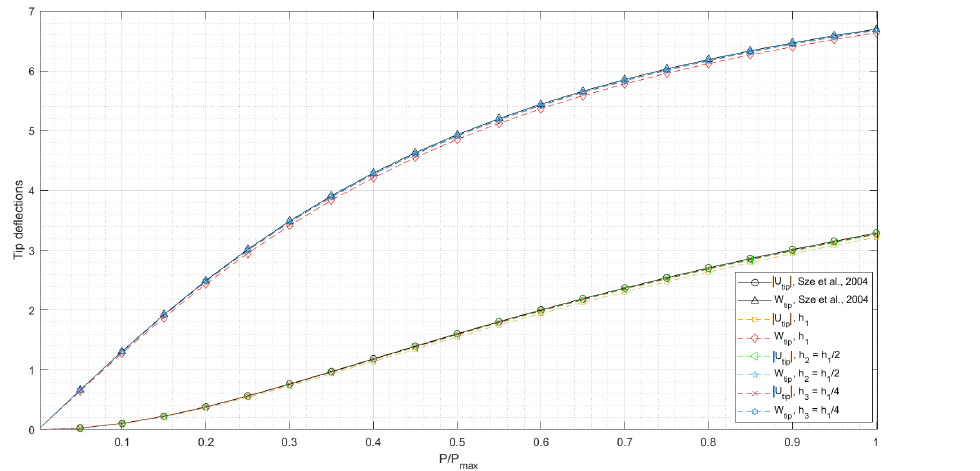
Figure 3. Load–deflection curves for the cantilever subjected to end shear force (conservative loading). U tip and W tip are the vertical and horizontal tip deflections. The values of U tip are negative.